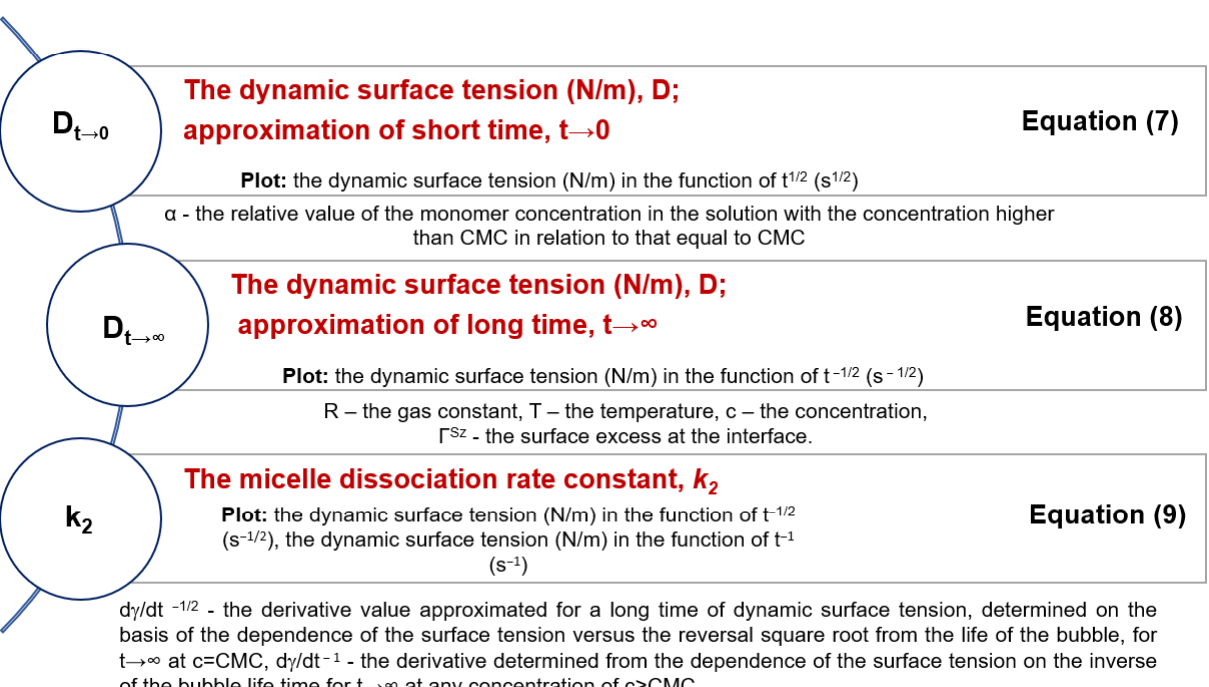
Figure 8. Characterization of the parameters used for diffusion determination in the ABS and ABSNa50 adsorption